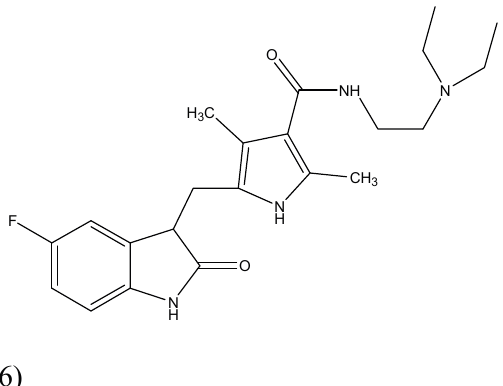
Figure 14. Structure of